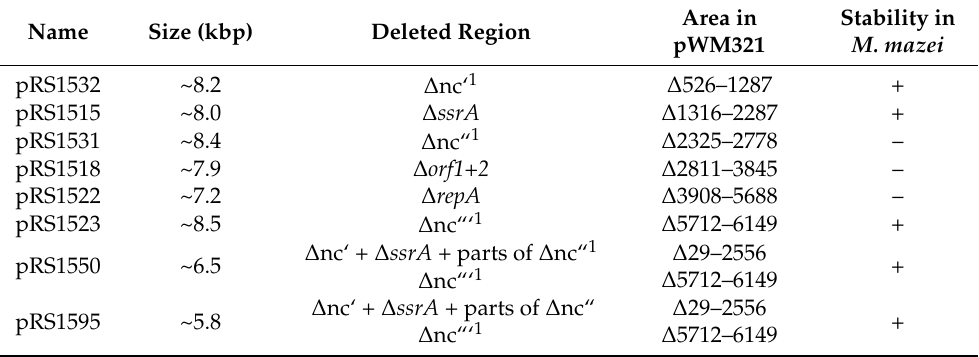
Table 1. Plasmid derivatives. Each plasmid misses one (or in the case of pRS1550, several) region(s) of the original shuttle vector pWM321. After construction in E. coli and verification, the plasmids were transformed in M. mazei , with ‘+’ representing a successful transformation and stable replication and ‘–‘ meaning no transformants were